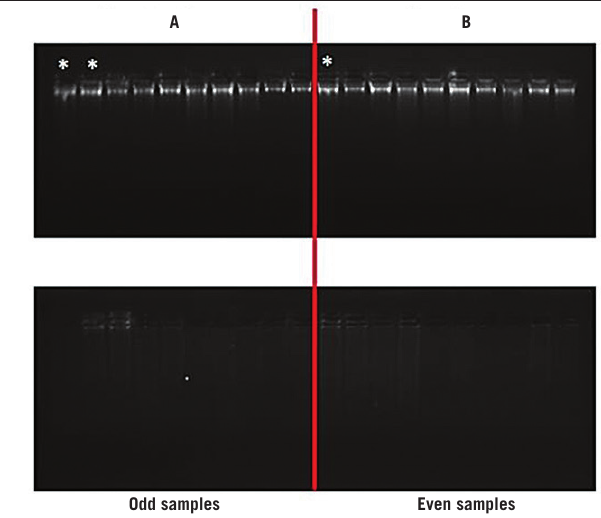
FigurE 3 − DNA bands run on 2% agarose gel A) PKM; B) kit.